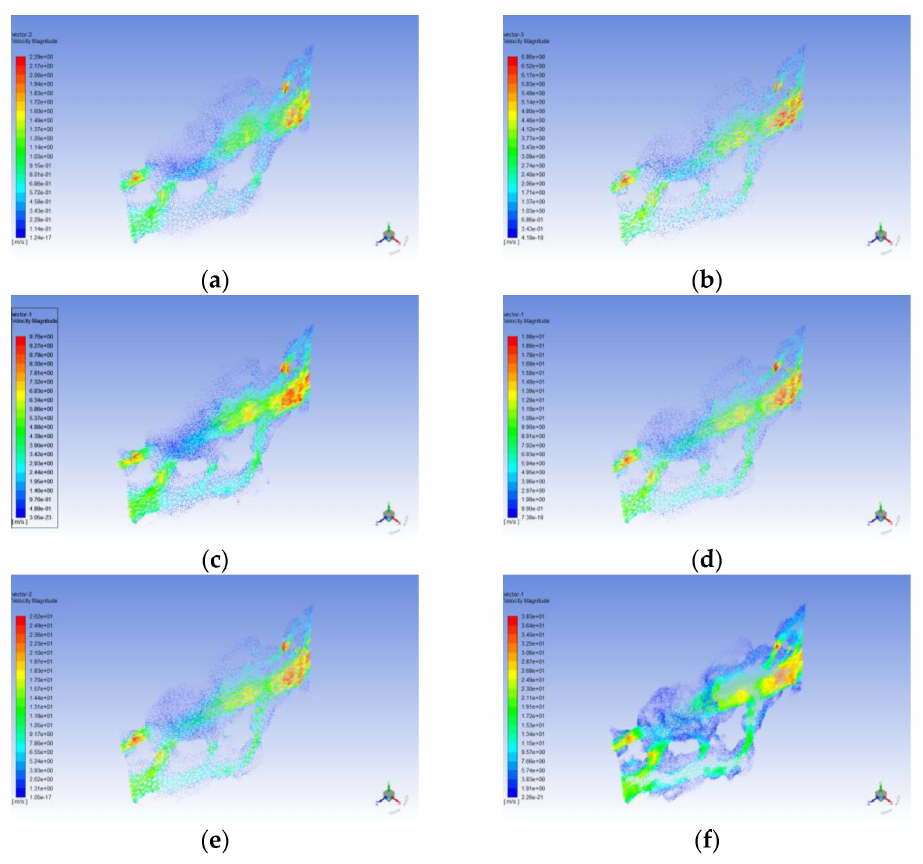
Figure 4. z forward inlet velocity vector diagram:( a ) 0.1 Mpa speed vector. ( b ) 0.5 Mpa speed vector. ( c ) 1 Mpa speed vector. ( d ) 3 Mpa speed vector. ( e ) 5 Mpa speed vector. ( f ) 10 Mpa speed vector illustration.